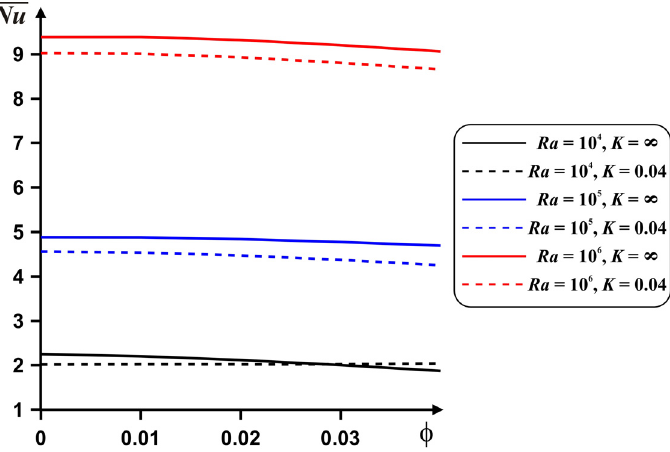
Figure 10. Dependences of the mean Nu on φ , Ra and K for δ = 0.5.